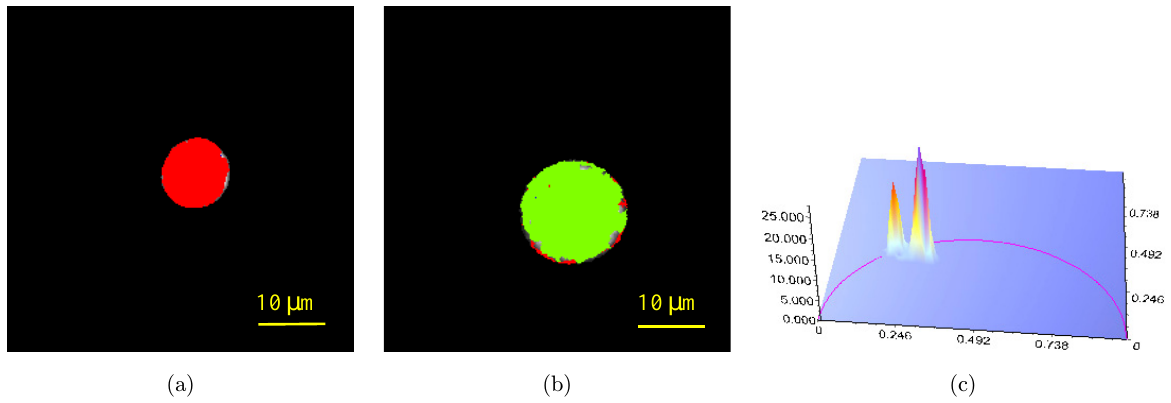
Fig. 9. FLIM images of °uorescent beads of di®erent colors and sizes dispersed in a scattering silicone tissue phantom. FLIM image of a 10 (cid:1) m red bead acquired at the depth of 1.2 mm (a). FLIM image of a 15 (cid:1) m yellow-green °uorescent bead acquired at the depth of 3 mm (b). Phasor-plot